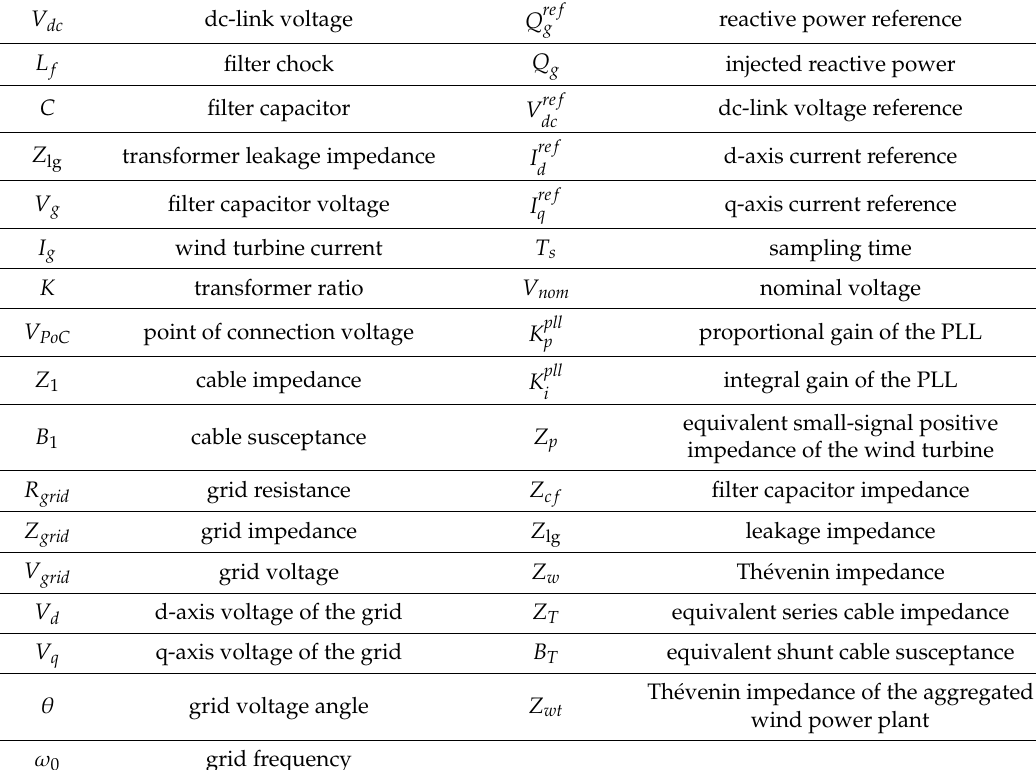
Table A1. Definition of the variables and parameters used in the